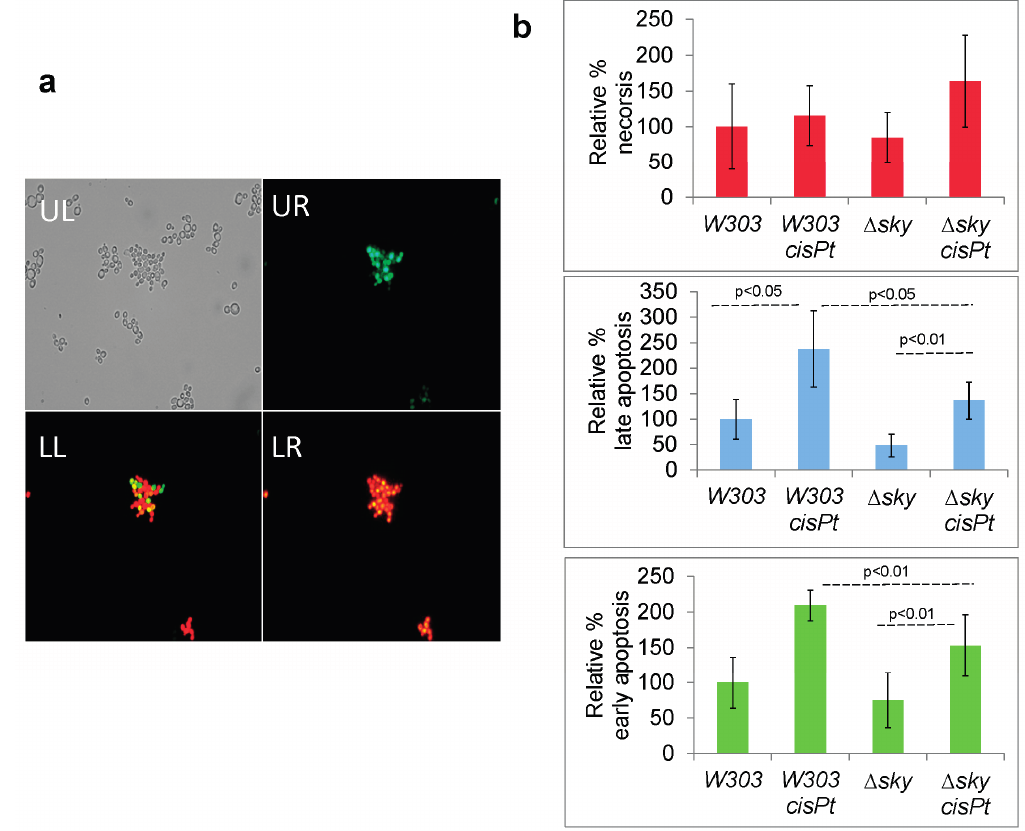
Figure 3. Apoptosis and necrosis induced by cisplatin ( cisPt ) in W303-1A ( W303 ) and ∆ sky1 strains ( a ) apoptosis or/and necrosis visualized by fluorescence microscopy (objective 40×): UL, Bright field; UR Green channel for YO-PRO ® -1 staining; LR, Red channel for PI staining; LL Merge; ( b ) Quantification of necrosis, late apoptosis and early apoptosis by flow